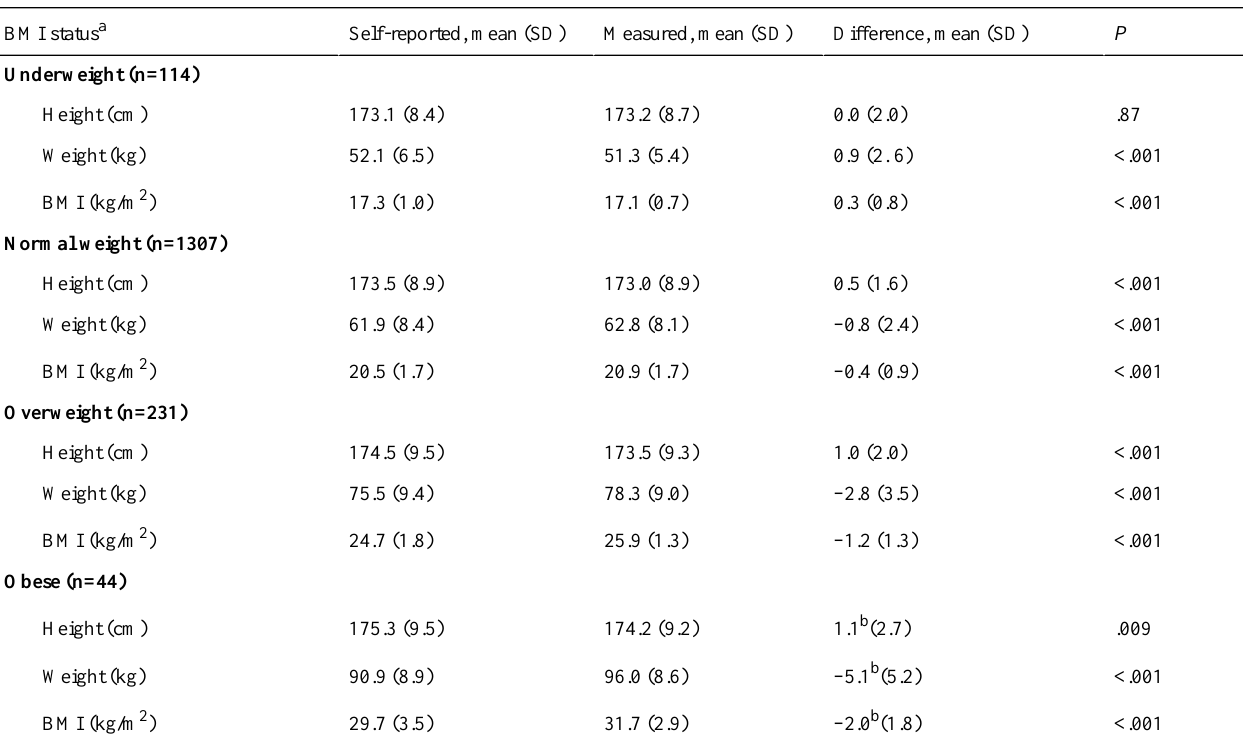
Table 3. Mean of self-reported and measured height, weight, and BMI by measured BMI status.